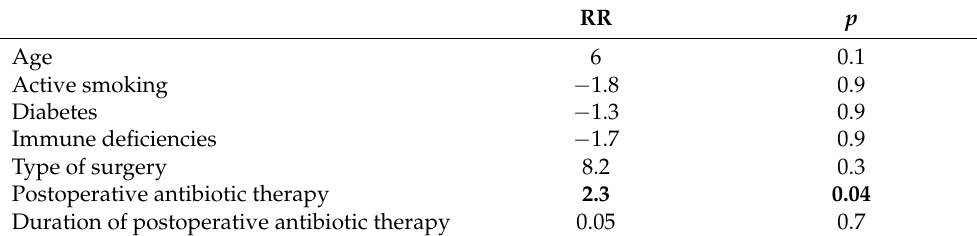
Table 3. Multivariate